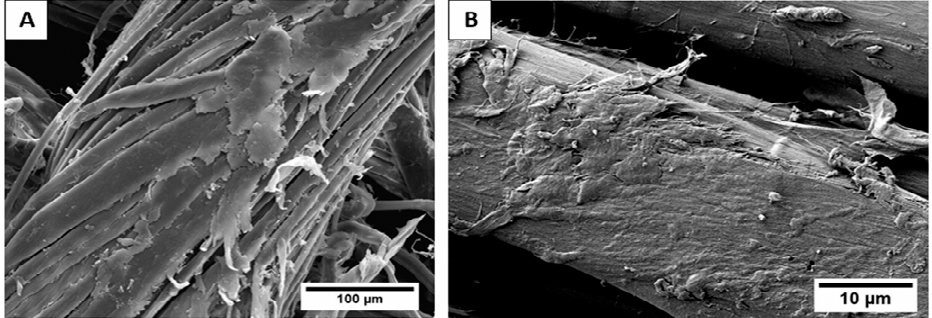
Figure 1. SEM micrographs showing the untreated flax yarn ( A ) and a detail of the flax fiber surface ( B ).